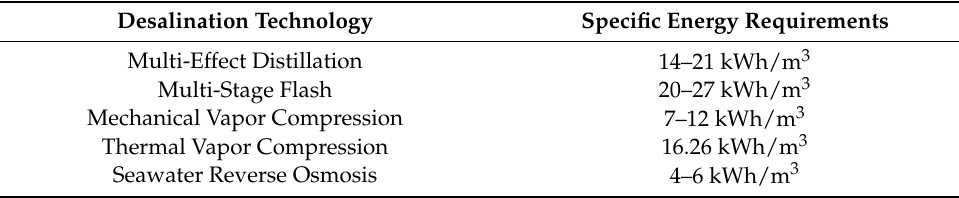
Table 2. Typical total electrical energy consumptions in different desalination technologies.